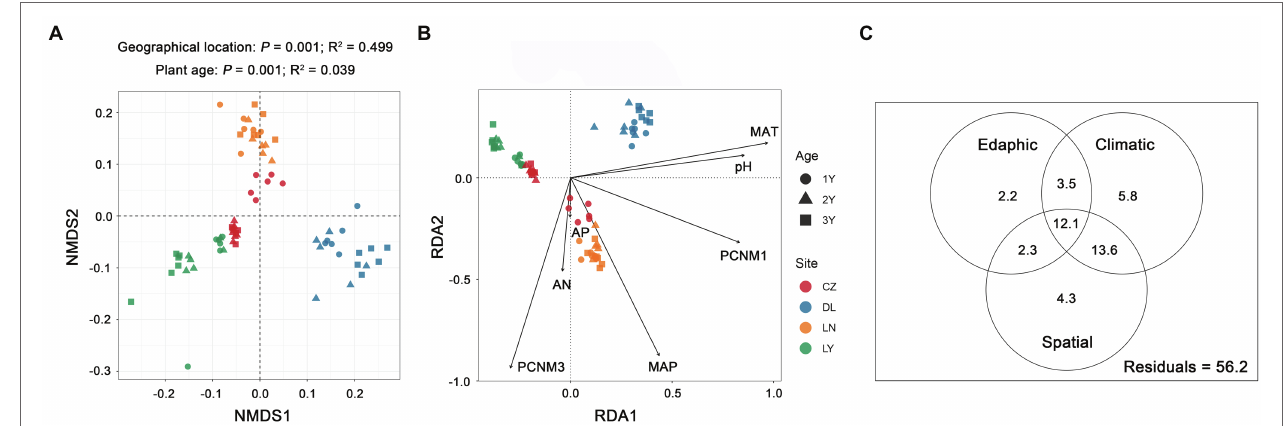
FIGURE 3 | Variation in the rhizosphere bacterial communities of S. flavescens . (A) Nonmetric multidimensional scaling (NMDS) ordination of the rhizosphere bacterial communities based on the Bray-Curtis distance matrix. (B) Redundancy analysis (RDA) revealing significant spatial, climatic, and edaphic variables shaping the rhizosphere bacterial communities. (C) Variation partitioning analysis (VPA) indicating the independent and interactive impacts (the percentage of variation explained) of the spatial, climatic, and edaphic factors on the rhizosphere bacterial communities. LN: Lingyuan; CZ: Changzhi; DL: Dali; LN: Luonan. 1Y: 1-year-old; 2Y: 2-year-old; 3Y: 3-year-old. PCNM: principal coordinates of neighbor matrices; MAT: mean annual temperature; MAP: mean annual precipitation; AN: available N; AP: available P.